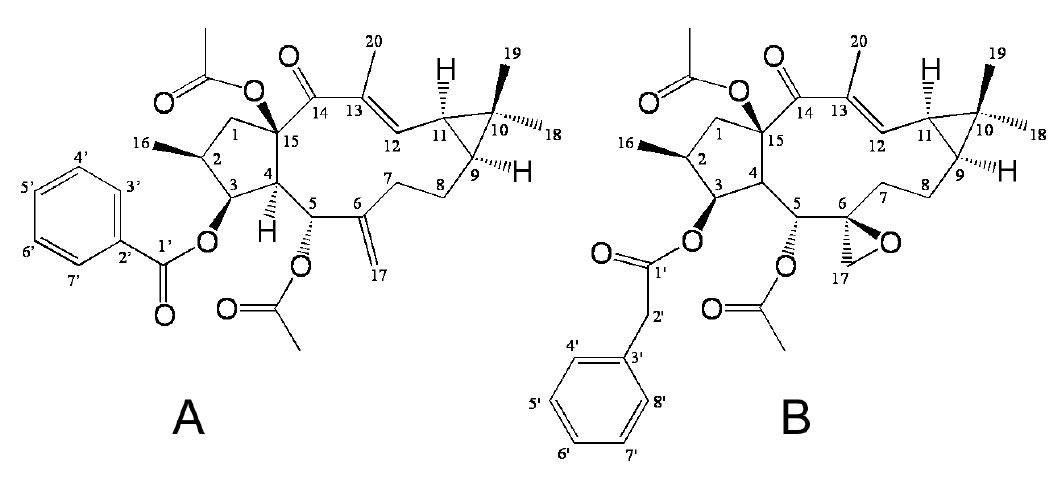
Figure 1. The chemical structure of Euphorbia factor L3 (EFL3, 1A) and Euphorbia factor L1 (EFL1,